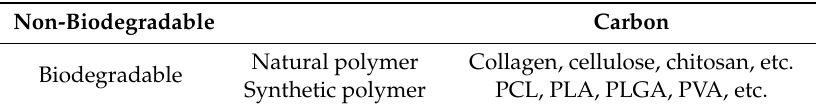
Table 1. Elecrospun nanofiber sca ff olds.